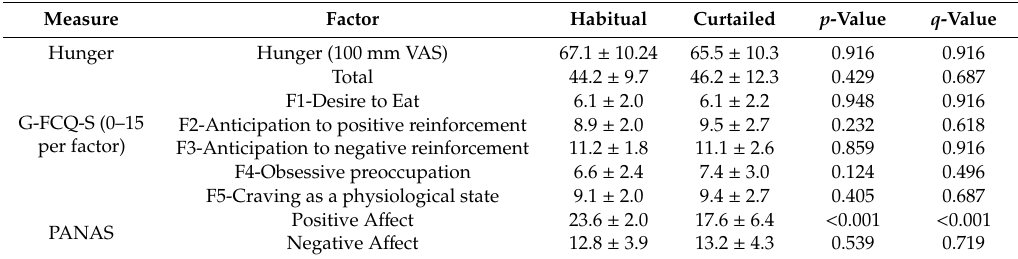
Table 4. Summary of state-dependent